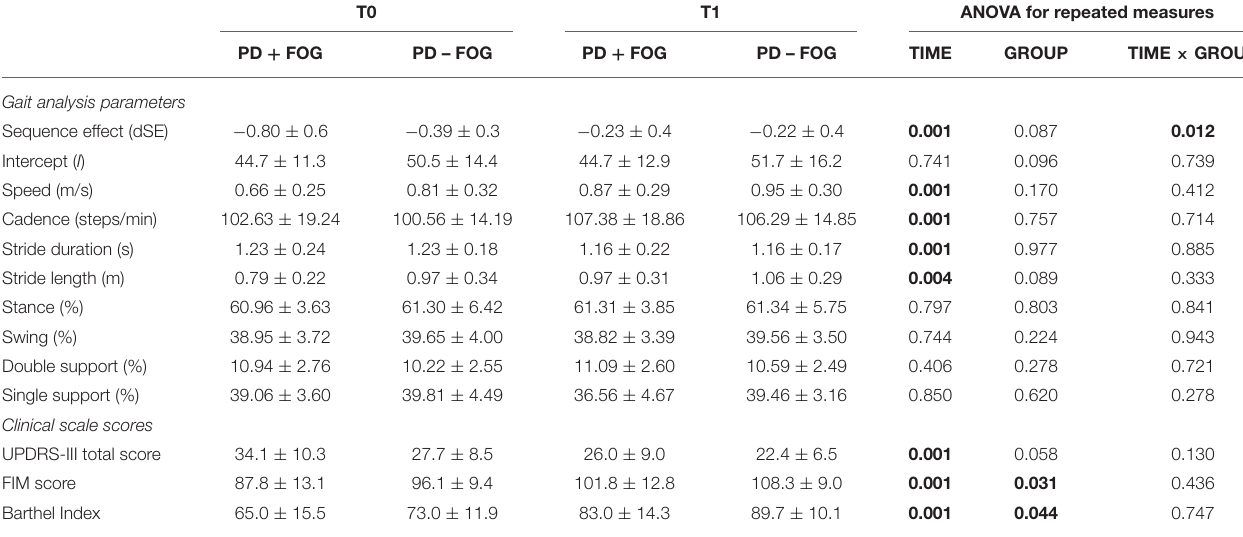
TABLE 3 | Effect of the rehabilitation program on gait parameters and clinical scale scores. T0 T1 ANOVA for repeated measures